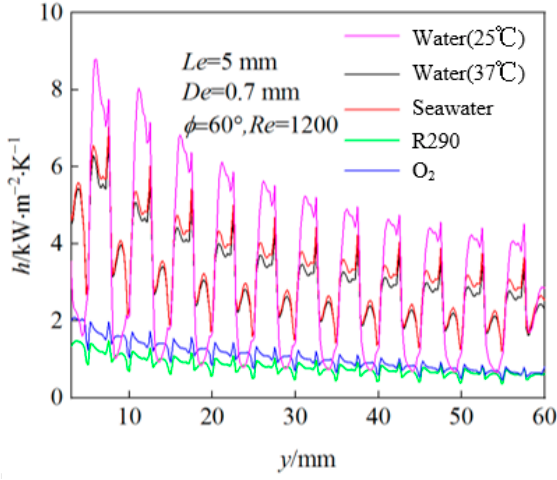
Figure 9. Local heat transfer coefficient h for fluids on the triangular corrugated plate.